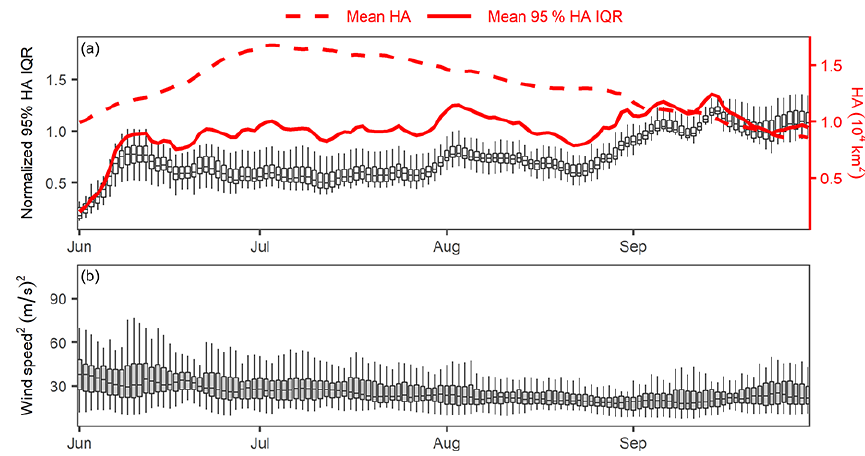
Figure 6. (a) Box plots represent the daily pseudo-forecasted normalized IQR (IQR/HA), including the uncertainty due to variability in the parameters, riverine inputs, and meteorology. The red dashed and solid lines show the daily mean HA and (non-normalized) IQR, respectively. (b) Box plots show 14d weighted-average-squared wind speed near the western shelf section. Box plots represent the interannual variability in the results. The center of each box is the median, while the whiskers extend to the extreme value or 1.5 times the IQR of the corresponding variable (whichever is